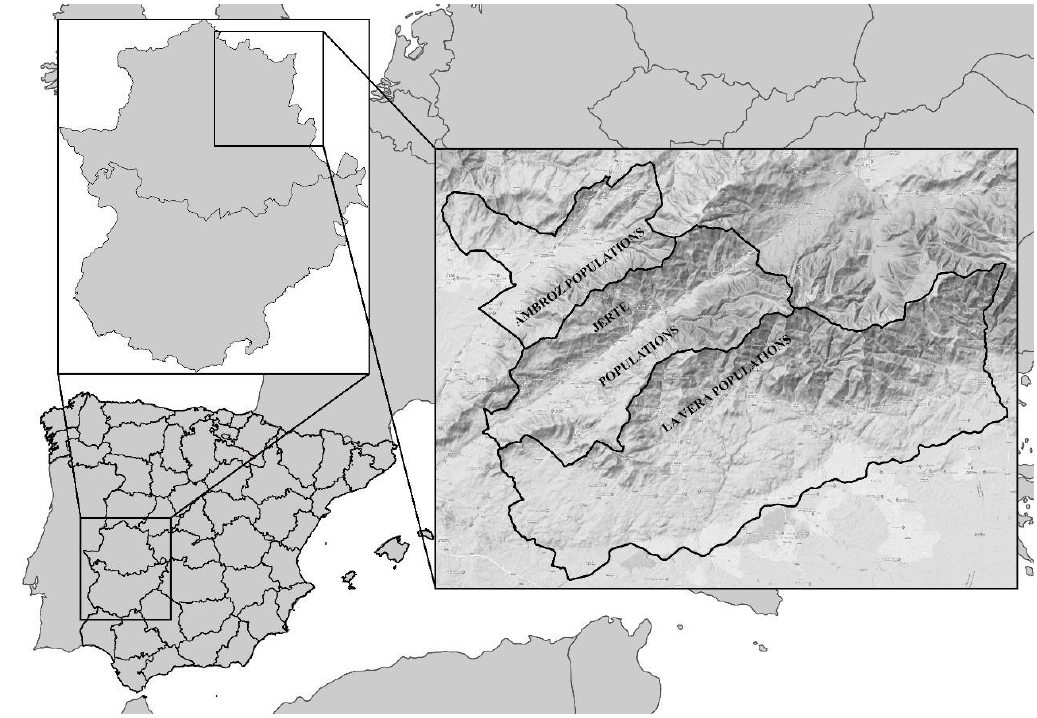
Figure 1. Map locating the three districts with Iberian desman populations in the north of Extrema- dura.